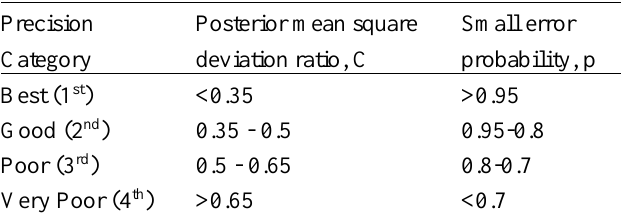
Model Evaluation Indicators (Adapted from ref. [5]) Precision